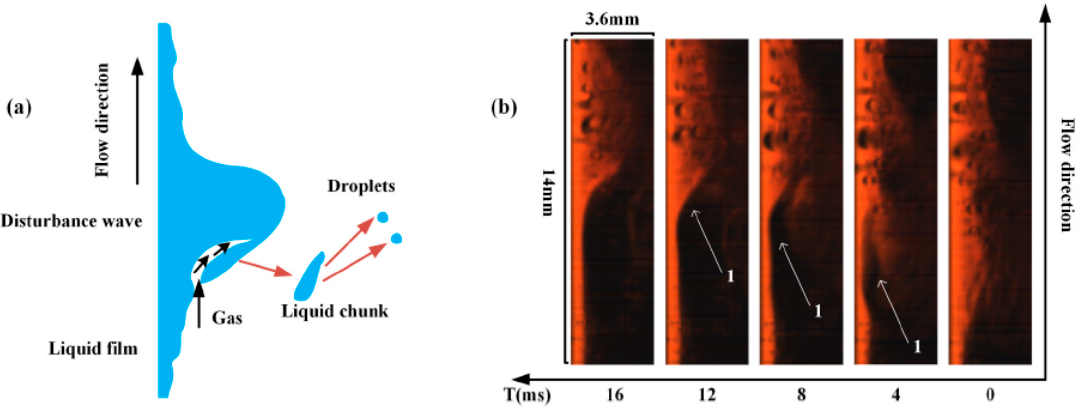
Figure 8. PLIF images in upward annular flow [51]. The event is interpreted as entrainment due to “shearing of the ending of the disturbance wave”. ( a ) A sketch illustrating the proposed interpreta- tion; ( b ) A sequence of raw PLIF-images with part of a wave image disappearing. ( b ) A sequence of raw PLIF-images with part of a wave image